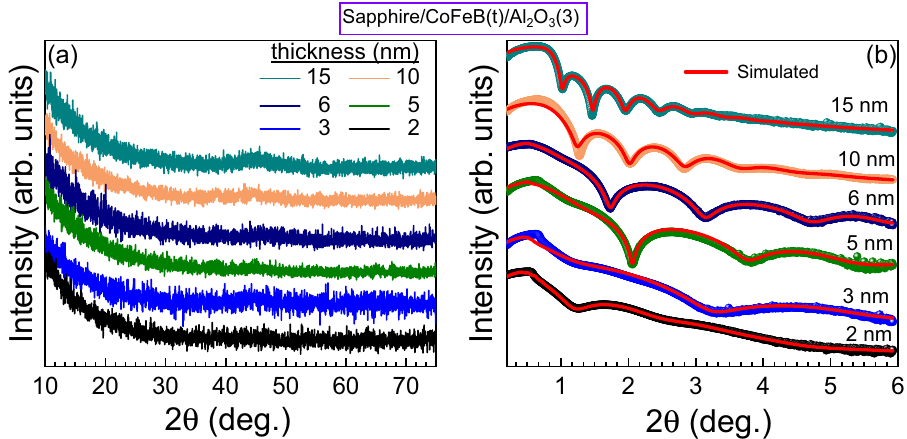
Figure 2. ( a ) XRD spectra for our emitters with different nominal thicknesses of CoFeB, and ( b ) XRR spectra for our emitters with different nominal thicknesses of CoFeB. Colored symbols and red lines correspond to experimental observed and simulated data, respectively.